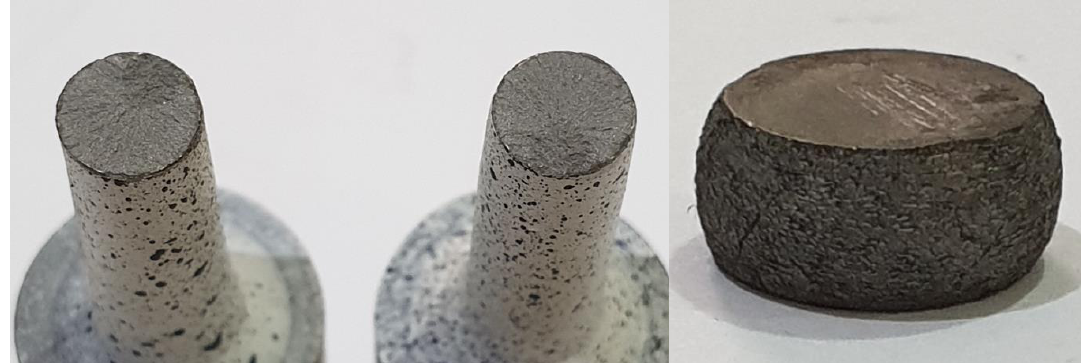
Figure 6. “D2” specimen under tension test. ( 1 ) Specimen before testing, ( 2 ) no necking prior to fracture, ( 3 ) specimen post fracture, and ( 4 ) the contour plot showing the Lagrange strain localization before fracture in red (maximum stain) and purple (minimum strain).